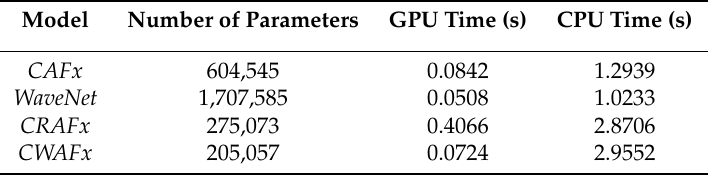
Table A1. Number of parameters and processing times across various